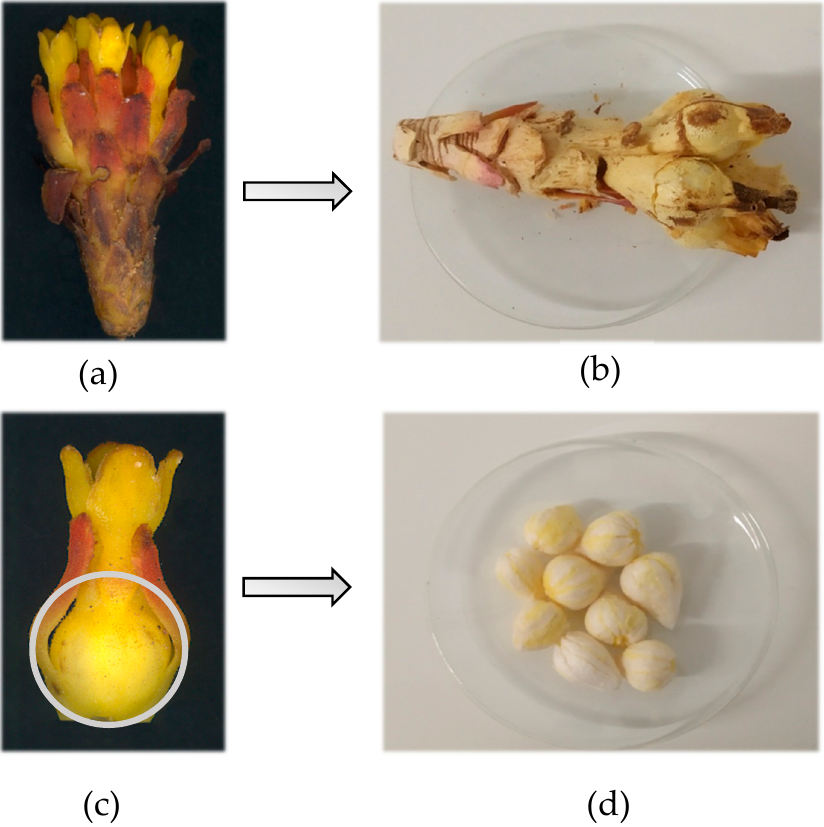
Figure 2. Cytinus hypocistis subsp. macranthus Wettst. (L.) L.: ( a ) fresh plant, ( b ) lyophilized plant, ( c ) fresh flower, and ( d ) lyophilized nectar.